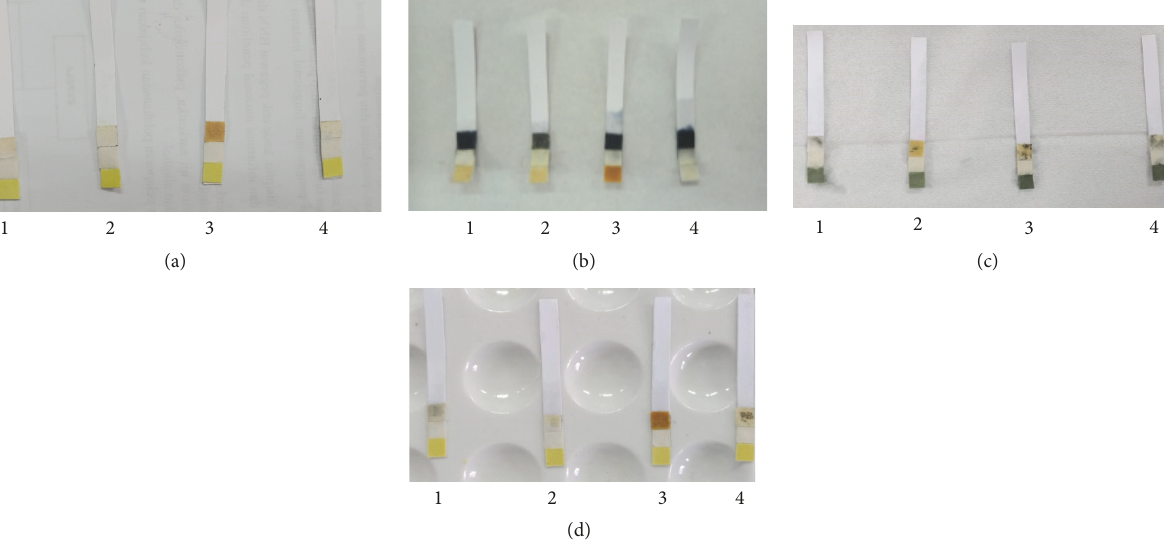
Figure 5: The selectivity of PAD in different papers: (1) Whatman No. 1, (2) Whatman No. 4, (3) Whatman No. 6, (4) Whatman 1 Chr. The PAD gives a different color on (a) reagent, (b) allopurinol, (c) paracetamol, and (d)